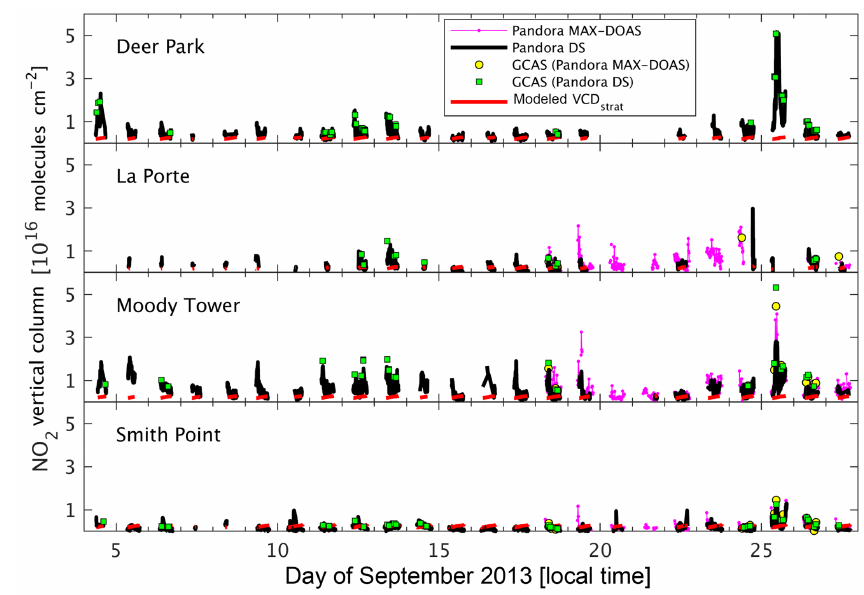
Figure 10. Tropospheric NO 2 columns from Pandora direct-sun (DS) and MAX-DOAS observations as a function of time between 4 and 27 September at Deer Park, La Porte, Moody Tower and Smith Point sites, and GCAS coincidences with those observations, as well as stratospheric NO 2 from a model at Pandora DS measurements. Pandora DS tropospheric columns are derived by removing the modeled stratosphere from the retrieved Pandora total